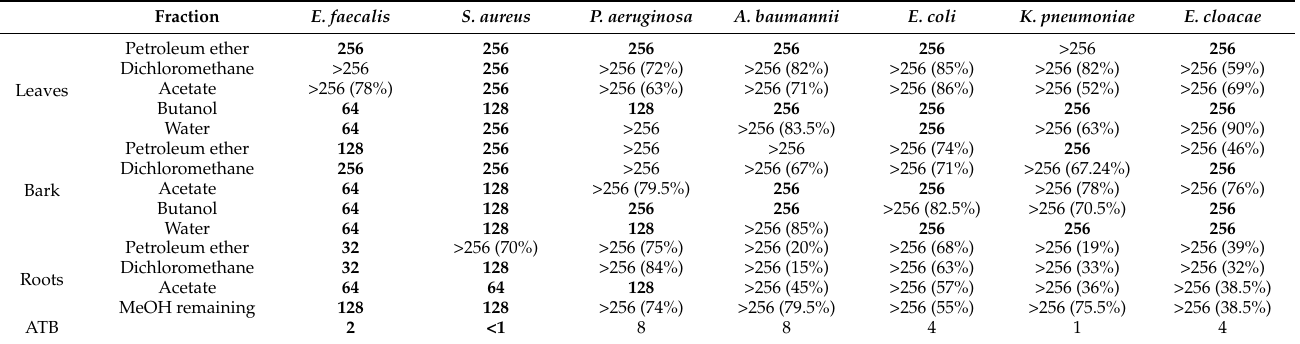
Table 2. Antibacterial activities (i.e., MIC in µ g/mL) of the fractions derived from the raw extract of Daniellia oliveri .